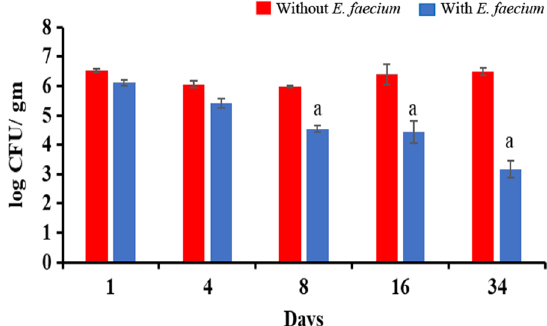
Fig. 3 Viable counts of S . enterica in chicken samples when stored at 7–8 ºC covered with films with and without viable cells of E. faecium . Error bars are representative of mean SD of the three independent ± experiments performed in triplicates. a Indicates significant (p < 0.05) difference between E. faecium and without E. faecium -treated samples of the same day